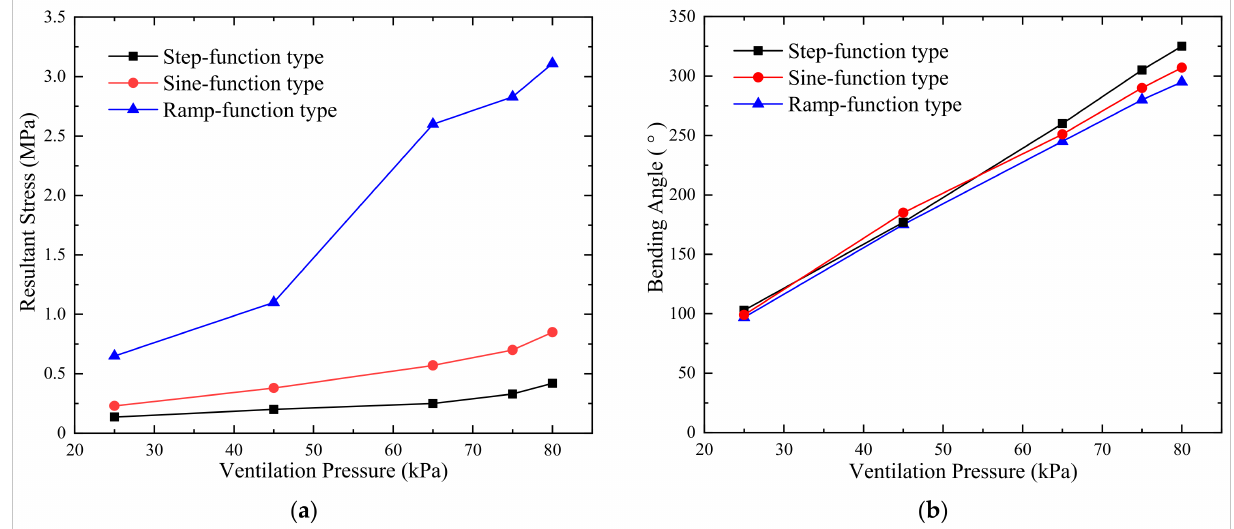
Figure 3. ( a ) Comparison of the resultant stress of the three kinds of soft manipulators; ( b ) bending angle of the three kinds of soft